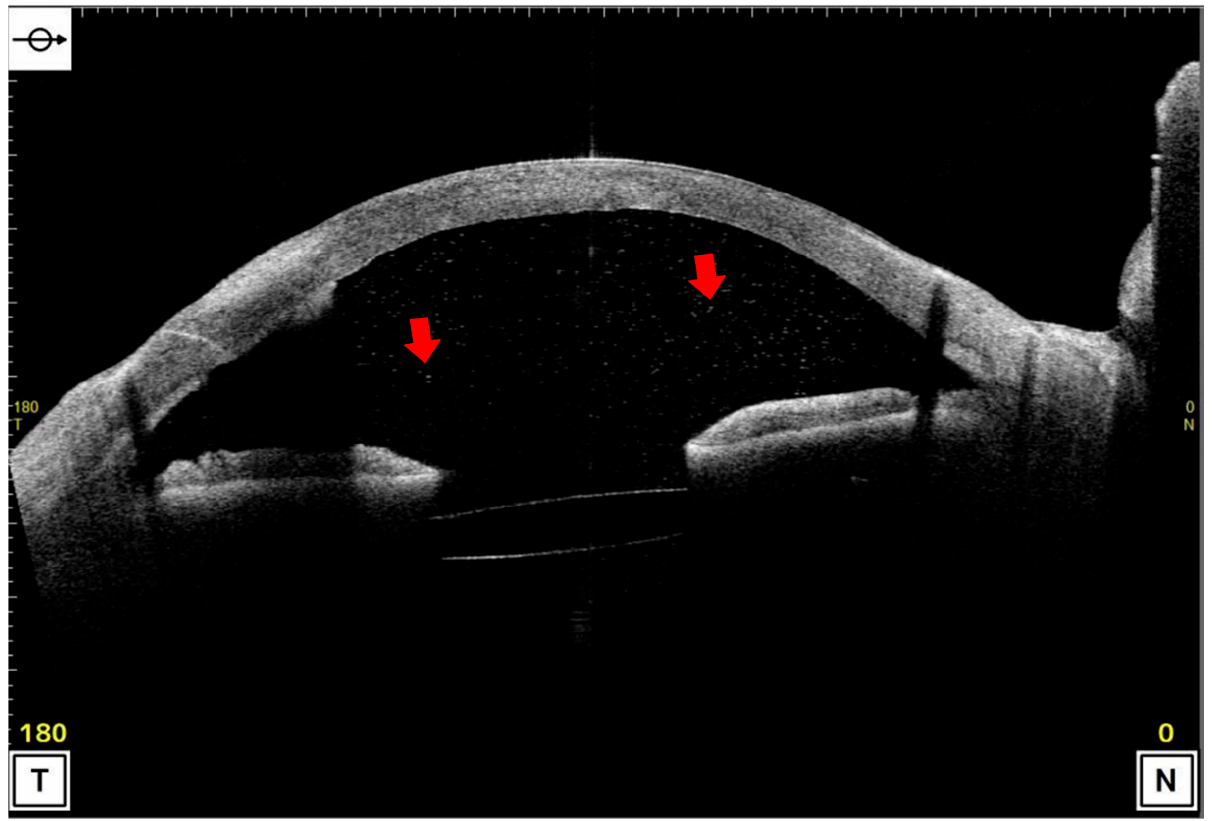
Figure 1. Case with particles in the anterior chamber. The finding in a case with particulate materials in the anterior chamber detected by ophthalmoscopy due to a corneal infection. When the anterior segment optical coherence tomographic (AS-OCT) images were examined, many particles considered to be inflammatory cells were found in the anterior chamber (indicated by arrows).